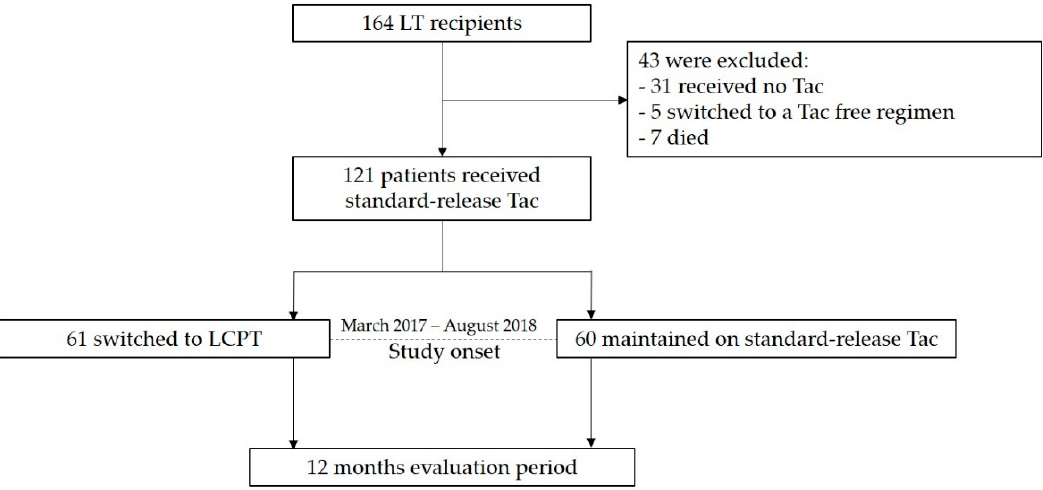
Figure 1. Study design and patient enrolment. A total of 164 liver transplant (LT) recipients were screened for eligibility. Only LT recipients who were started on IR- or ER-Tac (standard-release tacrolimus) and continued taking this drug until the beginning of the study were included.